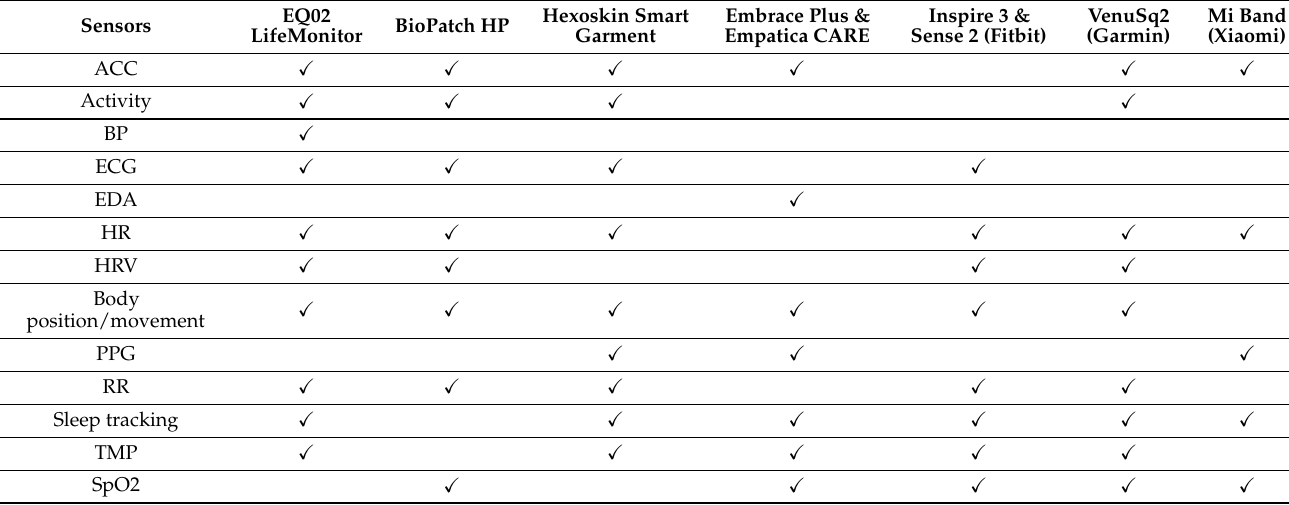
Sensors : accelerometer (ACC), blood pressure (BP), electrocardiogram (ECG), electrodermal activity (EDA), heart rate (HR), heart rate variability (HRV), photoplethysmography (PPG), respiratory rate (RR), skin temperature (TMP), and oxygen blood saturation